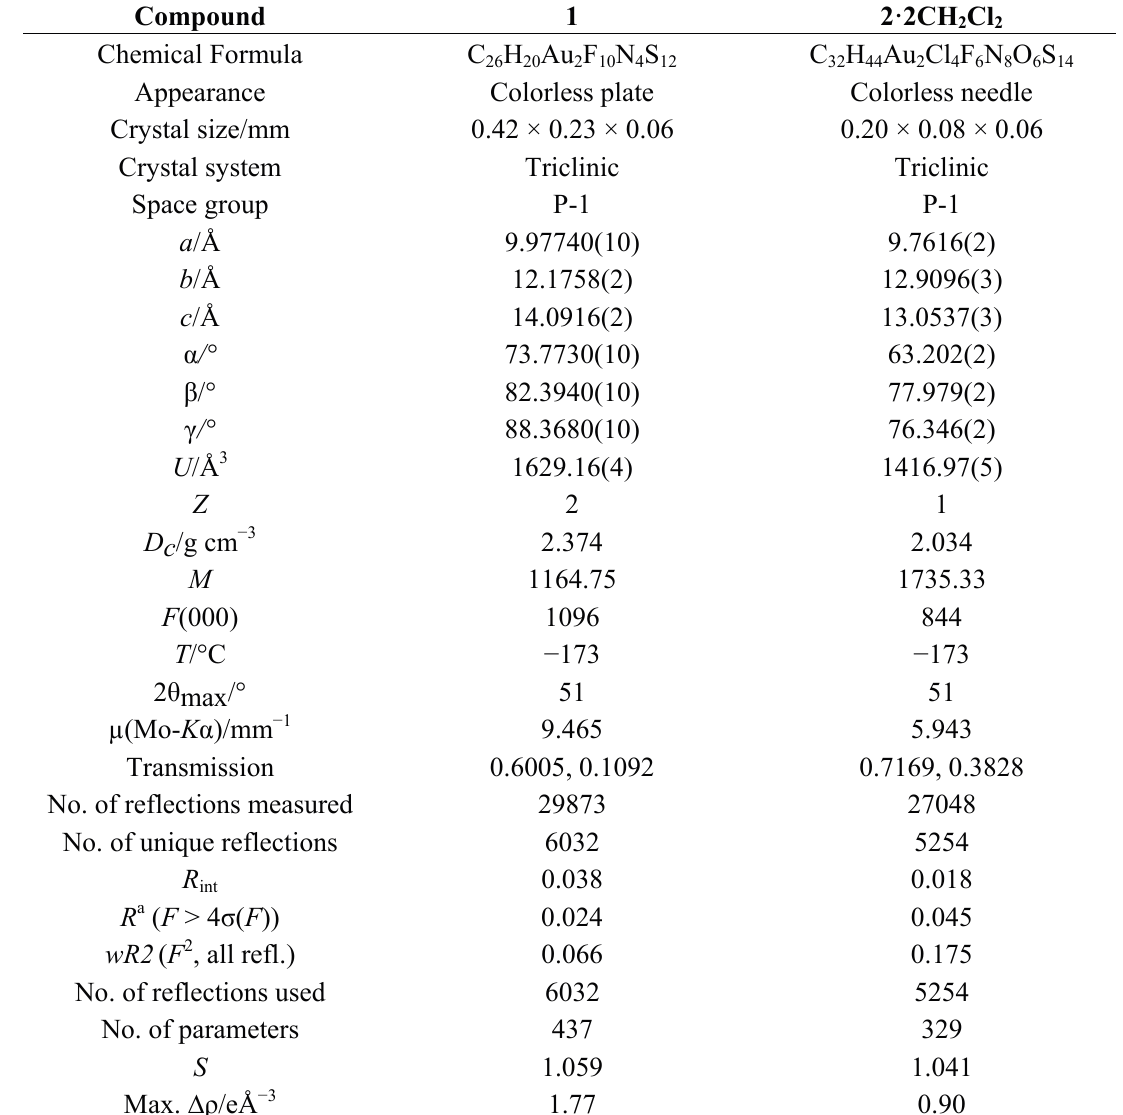
Table 3. Details of Data Collection and Structure Refinement for Complexes 1 and 2